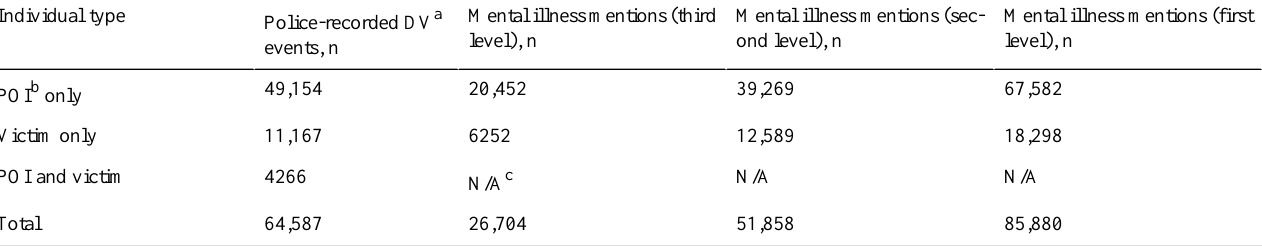
Table 1. Numbers of police-recorded DV events with mental illness mentions for POIs and victims (first column), and numbers of the mental illness for POIs and victims at various levels of the International Classification of Diseases-10